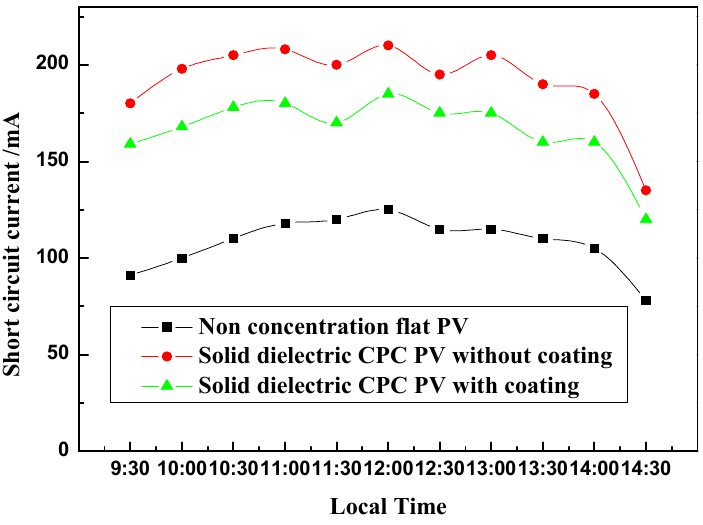
Figure 9. Changes in short circuit current with local